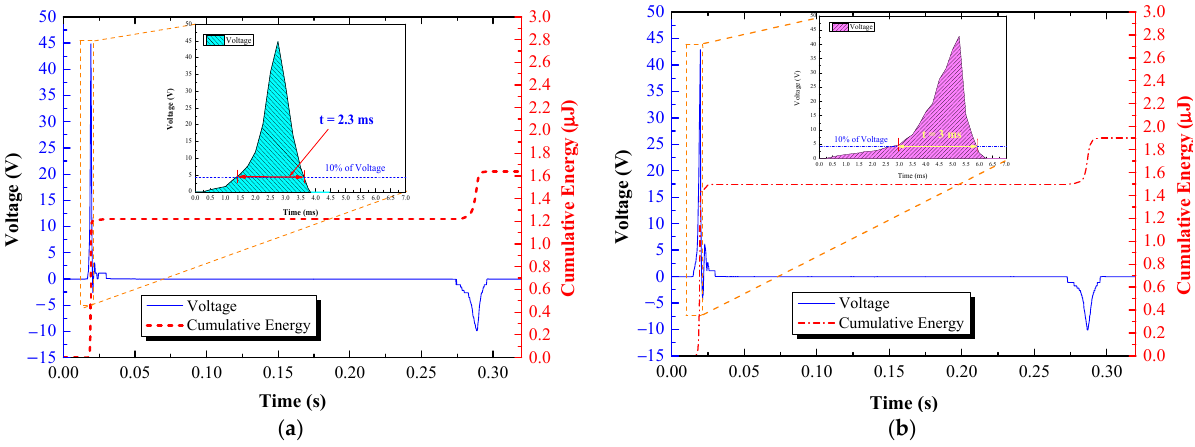
Figure 5. Output voltage and energy curve of TEHTB: ( a ) 0.1 mm thick PTFE layer; ( b ) 0.2 mm thick PTFE layer.